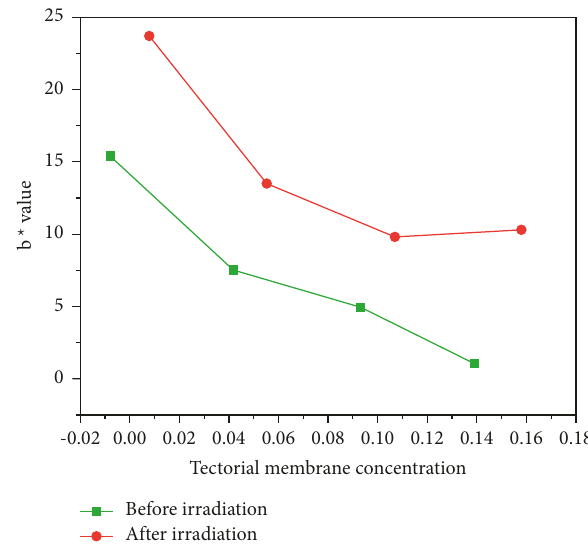
Figure 4: b ∗ value before and after the aging of samples coated 2 coated with nano-TiO 2 film with different concentrations of silicon and